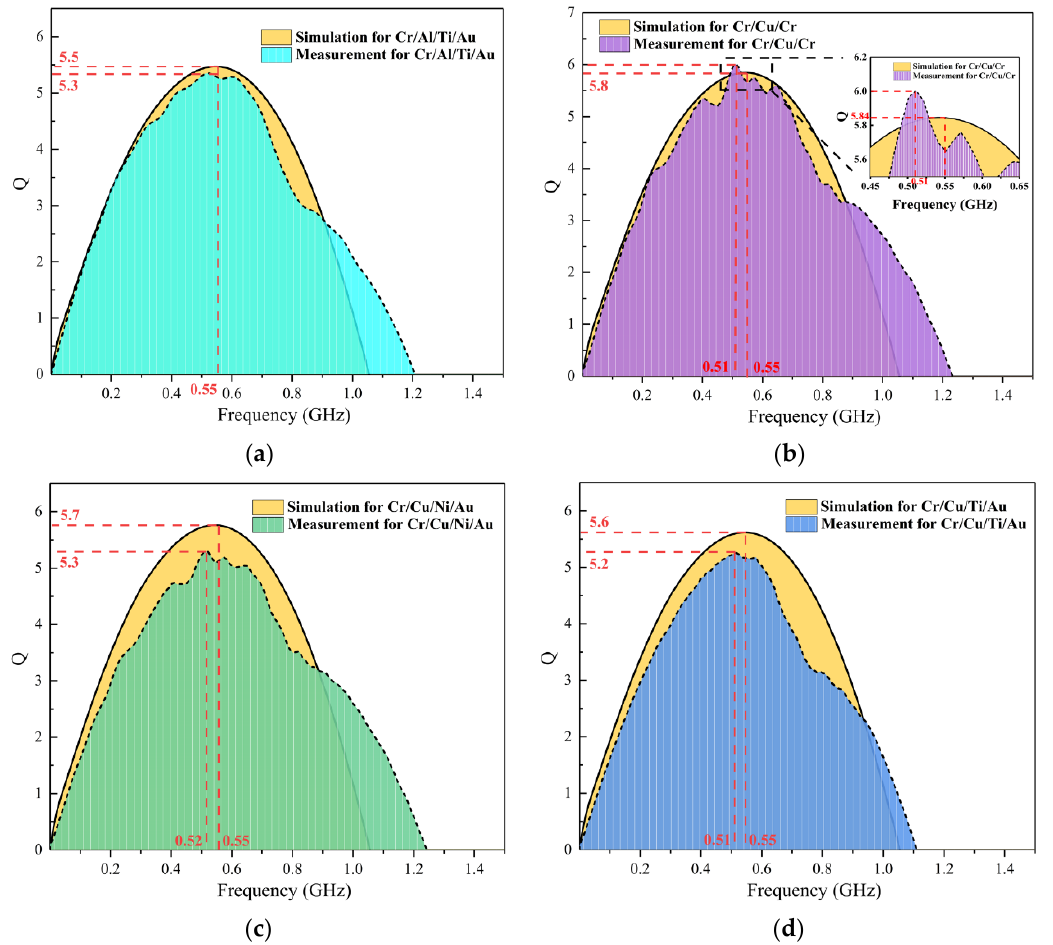
Figure 5. Comparisons between simulation and measurement results for the inductors fabricated by ( a ) Cr/Al/Ti/Au; ( b ) Cr/Cu/Cr; ( c ) Cr/Cu/Ni/Au and ( d ) Cr/Cu/Ti/Au, respectively.